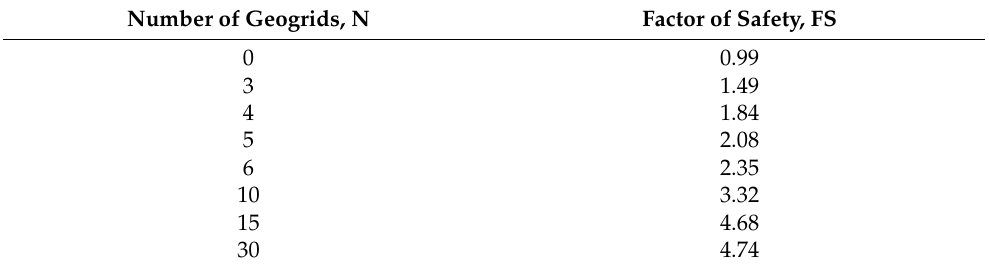
Table 7. Results of reinforced